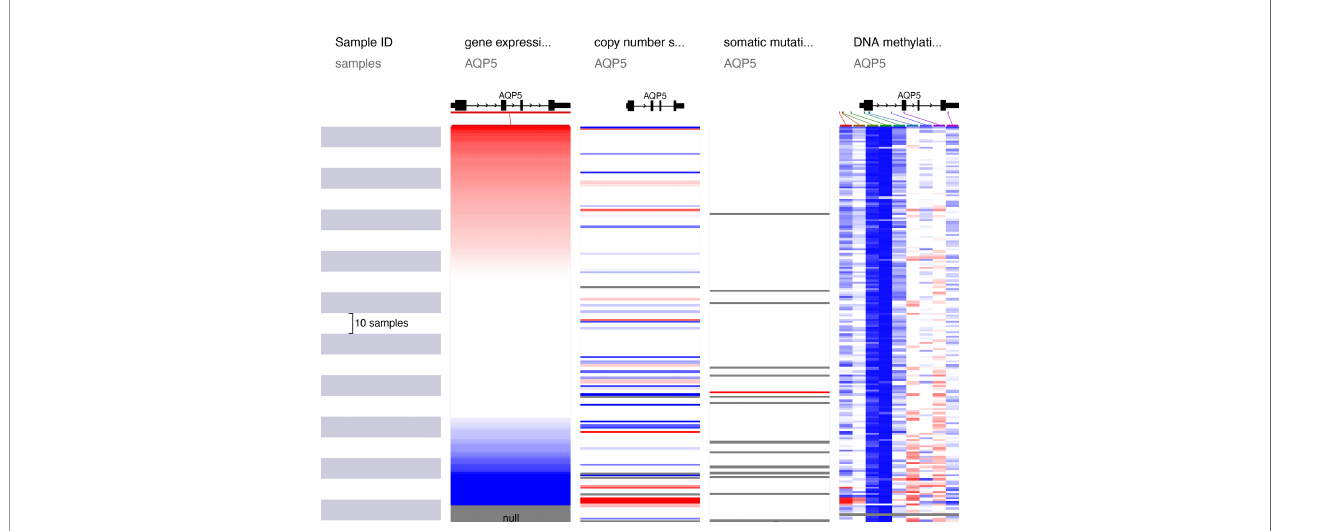
FIGURE 5 | The heatmap demonstrated the mutation, CNV, and methylation analysis of AQP5 in